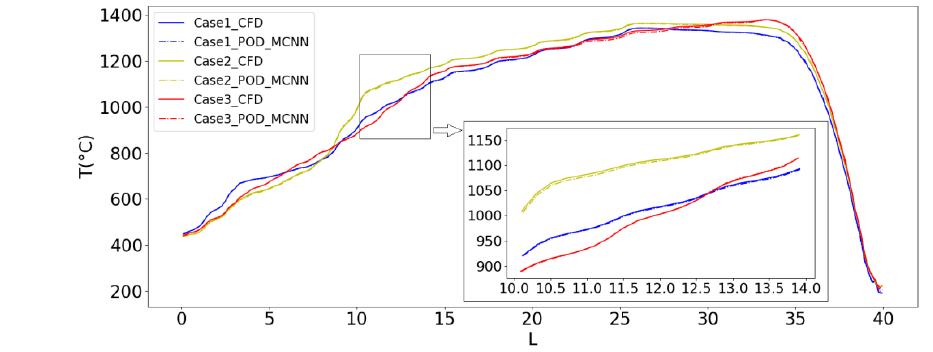
Figure 12. Temperature trend prediction results for three cases on test data.